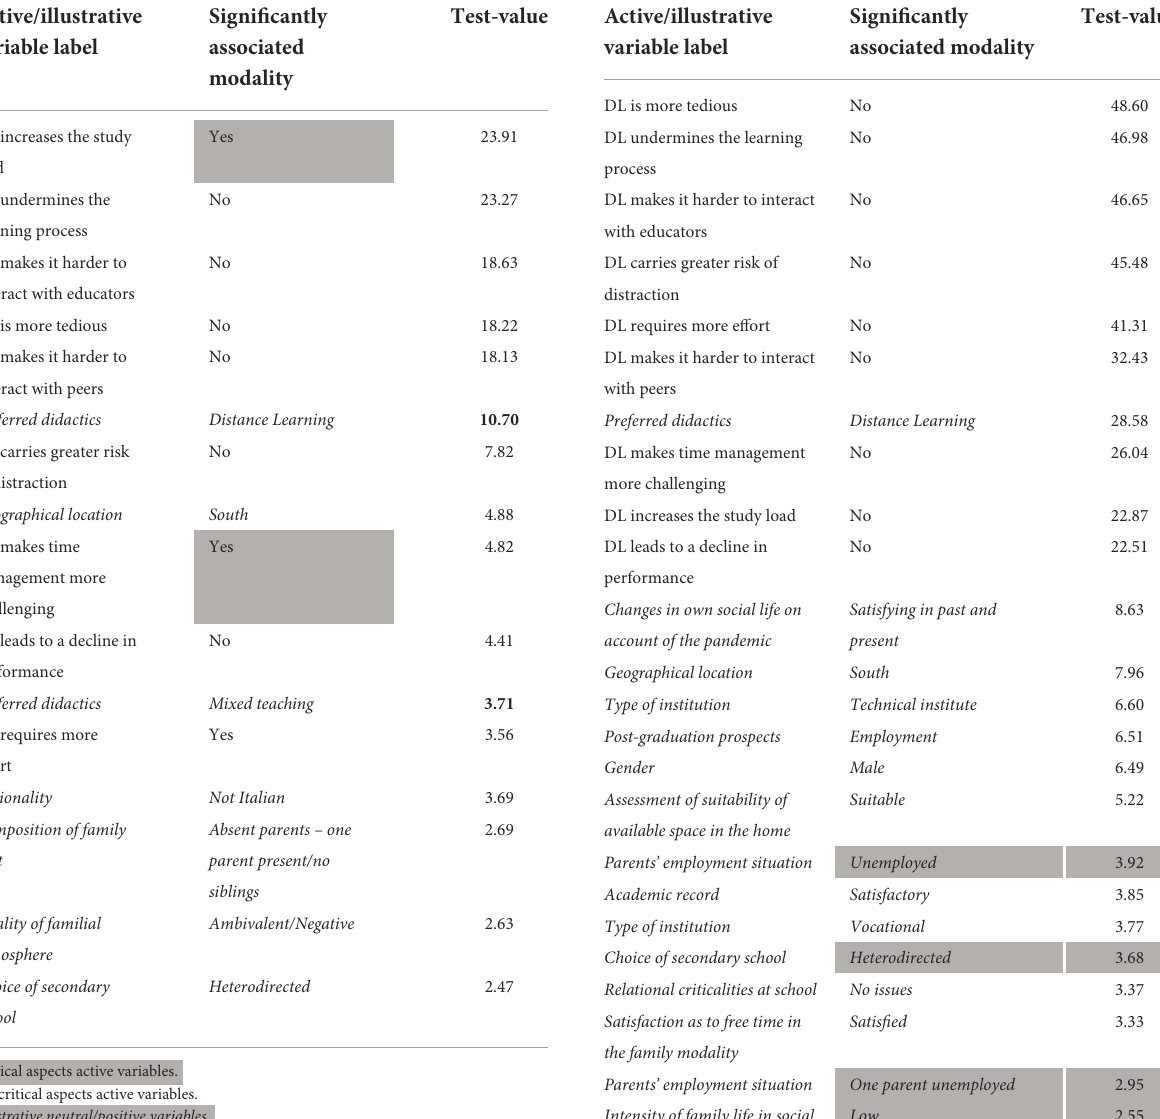
TABLE 3 Third group (18.7%): Consensual critics. TABLE 4 Fourth group (19.5%): Consensual